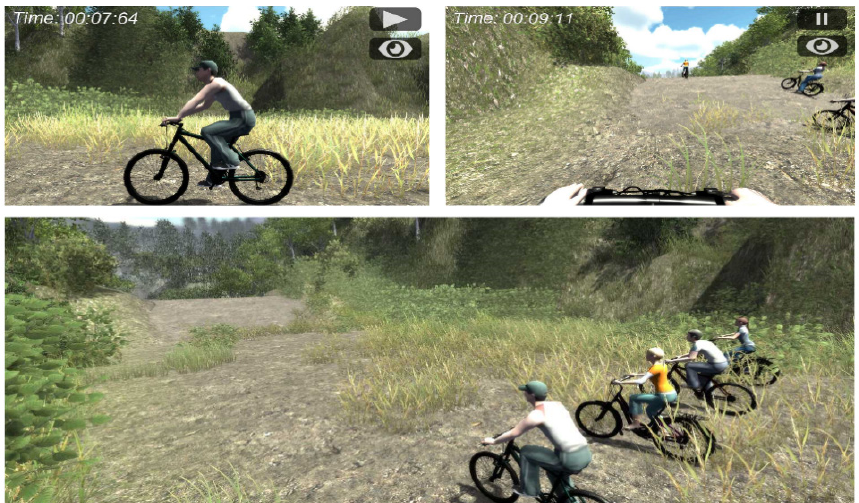
Figure 4. Training screenshots from two perspectives ( top left and top right ) and the exhibition of the virtual scene ( bottom ). There are three NPC in competition (three from right ). The top left corner of the screen displays the current training time, and two buttons in the top right corner are used for pausing training and switching perspective.